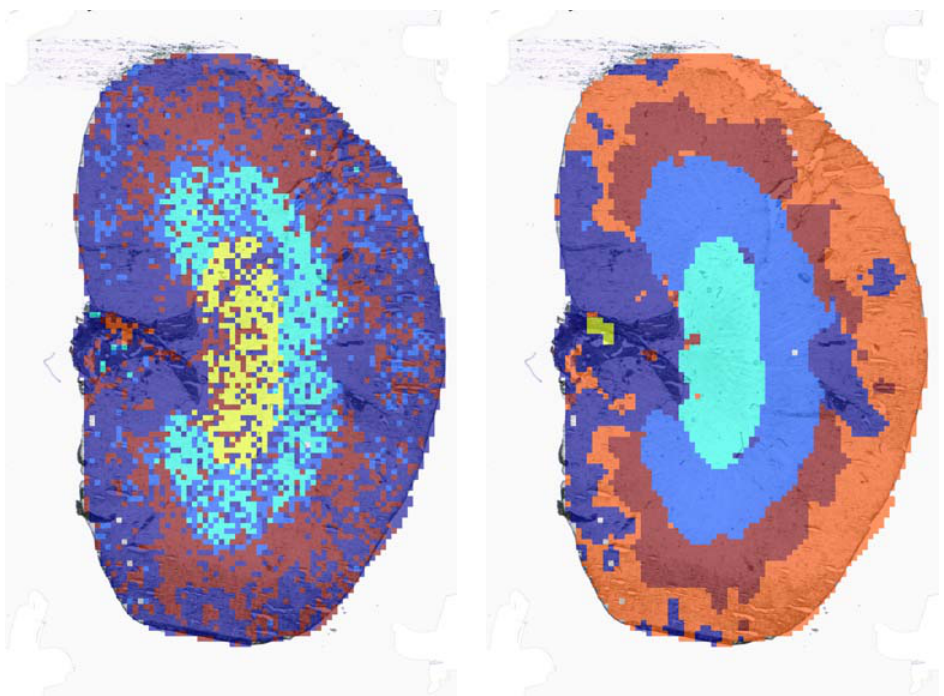
Figure 4: Comparison of clustering with and without previous smoothing. Left: Simple clustering does not recover the anatomical structure of the rat kidney section due to high-dimensional data, low spatial resolution (mixture of tissues) and multiplicative-like Poisson noise. Right: Locally- adaptive edge-preserving denoising of m/z images and following clustering preserves spatial struc- ture, i.e. edges and small details are not